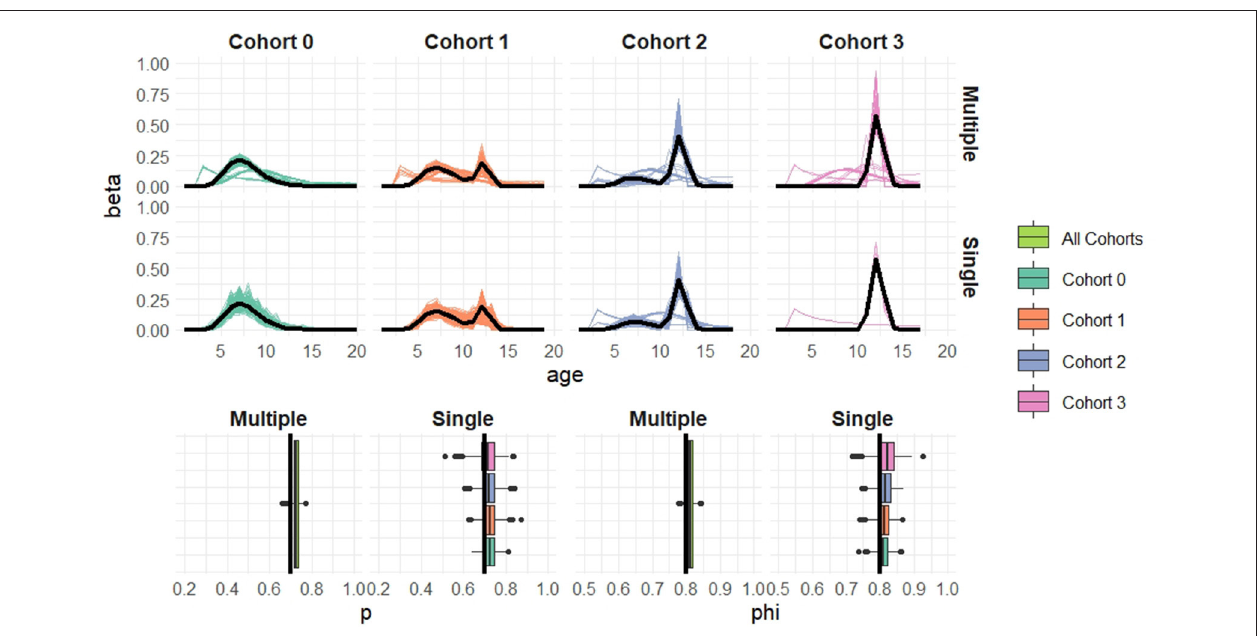
FIGURE 6 | Simulation results when cohort sample size n = 100 based on 1,000 simulated datasets. Top : Estimated recruitment distributions from the cohort-structured model. Middle : Estimated recruitment distributions from the single-cohort models. Bottom : Estimated capture and survival probabilities for the cohort-structured model (multiple) and separate single-cohort models (single). The true values are indicated by black